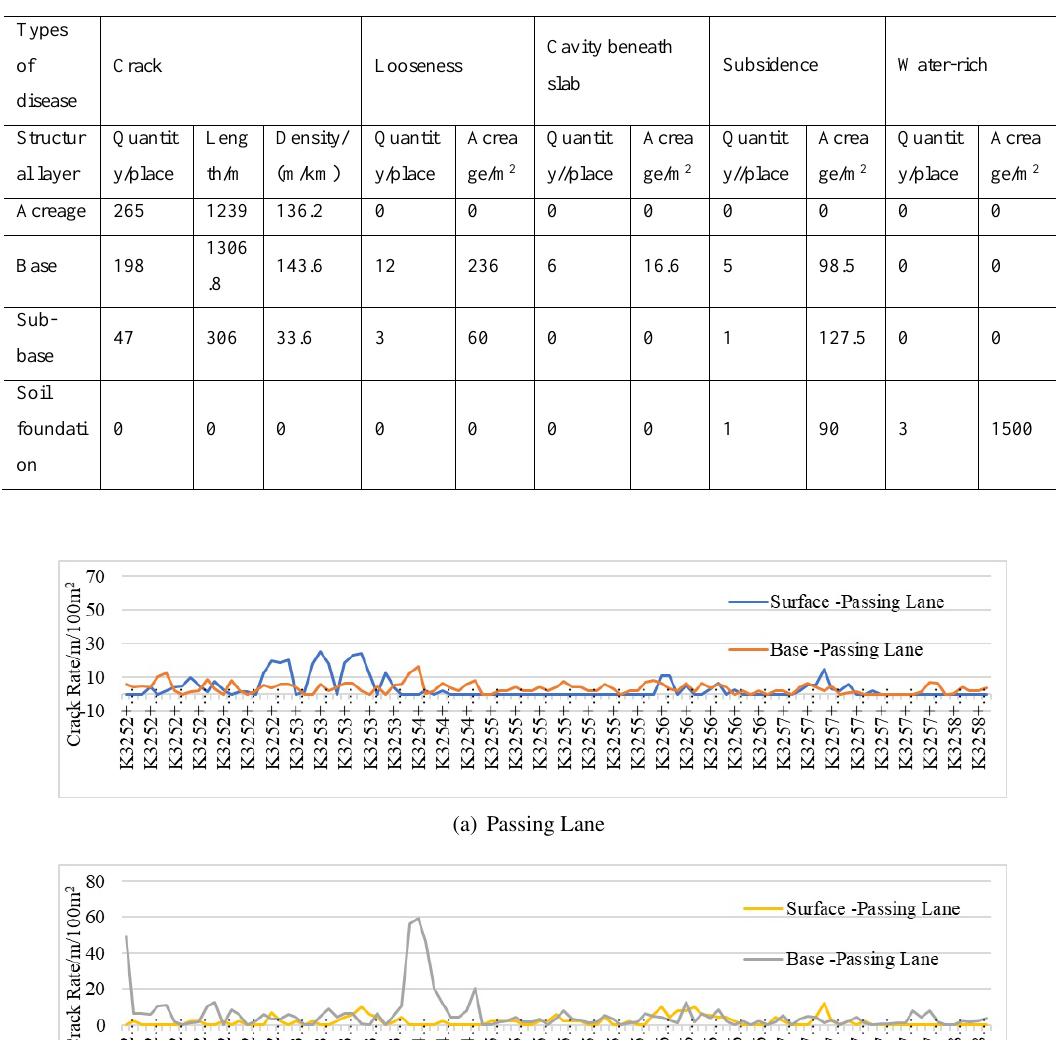
Table 3 Summary of Diseases Statistics in K3252 + 020 ∼ K3258 + 360 Section